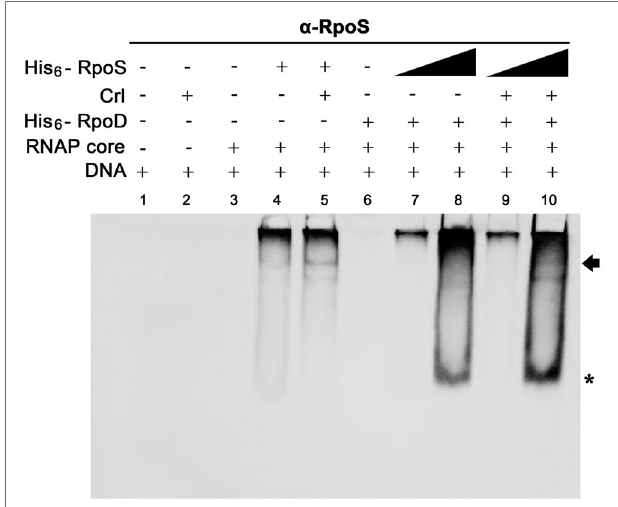
FIGURE 8 | Effect of Crl on the binding affinity of σ S to the P ssrA region in vitro . Competitive binding between His 6 -RpoS and His 6 -RpoD to the P ssrA region was re-examined in the presence of His 6 -Crl. In the absence of His 6 - RpoD (lanes 1–5), the RNAP core enzyme was incubated with 50 nM His 6 - RpoS, which was pre-incubated with 280 nM His 6 -Crl. In the competition between His 6 -RpoS and His 6 -RpoD (lanes 6–10), His 6 -RpoD was maintained at 50 nM, while His 6 -RpoS was used at 25 and 280 nM in combination with 280 nM His 6 -Crl. RNAP holoenzyme was reconstituted using different combinations of His 6 -Crl, His 6 -RpoS, and His 6 -RpoD and incubated with P ssrA region DNA. After gel electrophoresis, DNA was analyzed by EtBr staining ( Supplementary Figure 4 ), and His 6 -RpoS was localized using immunoblotting with an anti-RpoS antibody. His 6 -RpoS comprising E σ S cross- linked with the P ssrA region is indicated with an arrow, and free His 6 -RpoS is indicated by an asterisk.